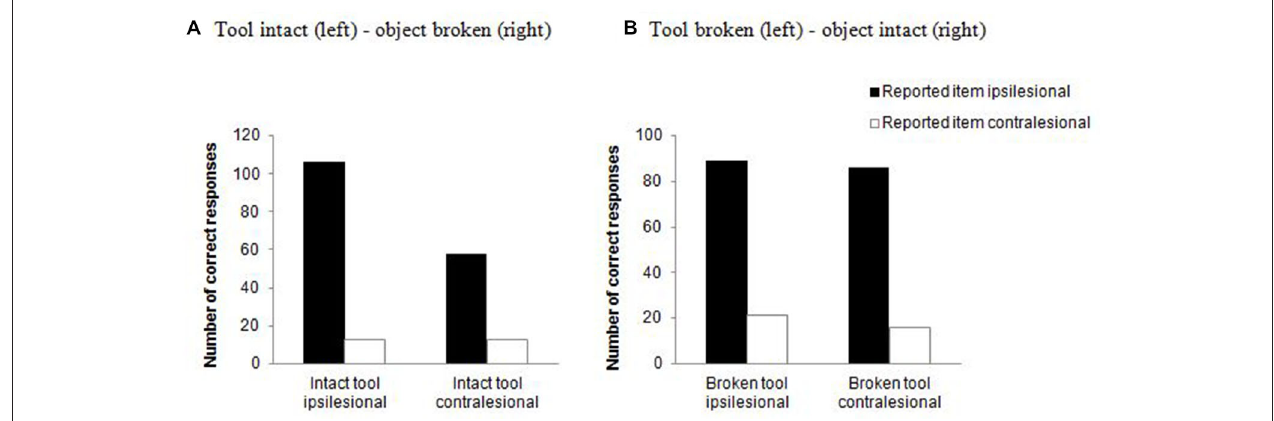
FIGURE 5 | Action-related objects only. Number of correct responses for two-item trials when only one item of an object pair was reported (either on the ipsilesional or on the contralesional side) as function of whether the tool handle was intact (A) or broken (B) .